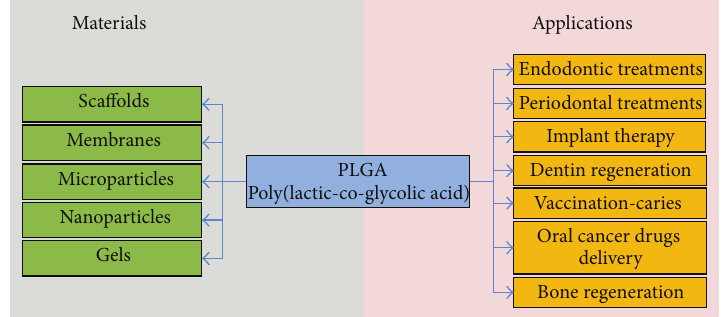
Figure 2: Most common PLGA materials and their applications in the dental